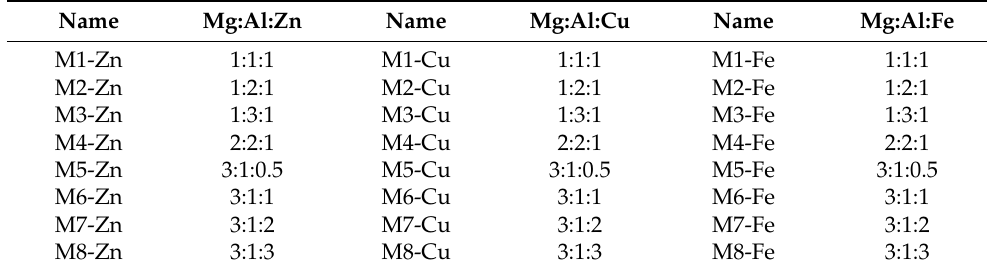
Table 1. M-MMH molar ratio and names of